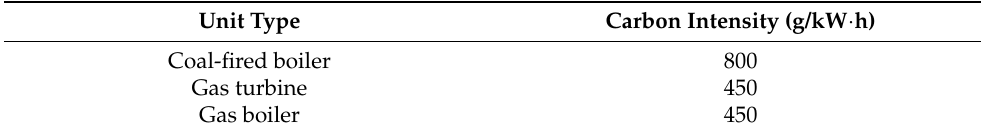
Figure 3. Forecast value of maximum output of wind turbines and photovoltaic units. (3) The carbon emission parameters of each unit are shown in Table 2: Table 2. Carbon emission parameters of each unit.